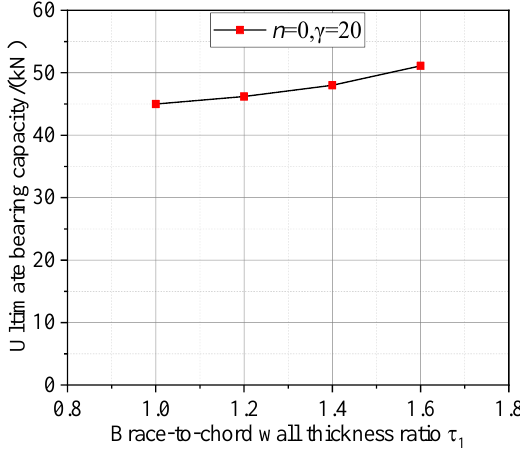
Figure 27. Effect of τ 1